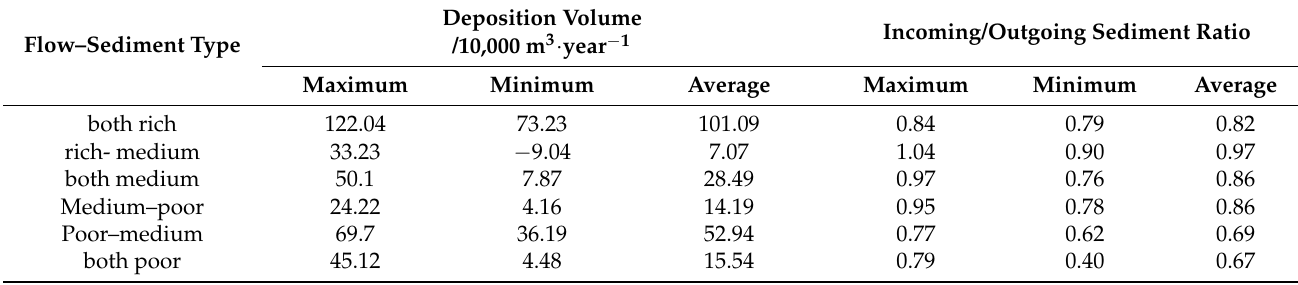
Table 4. Deposition and sediment delivery ratio of different flow–sediment year